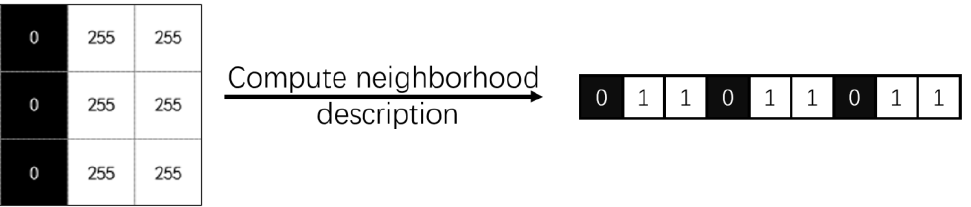
Figure 4. Neighborhood description descriptor calculation illustrate.